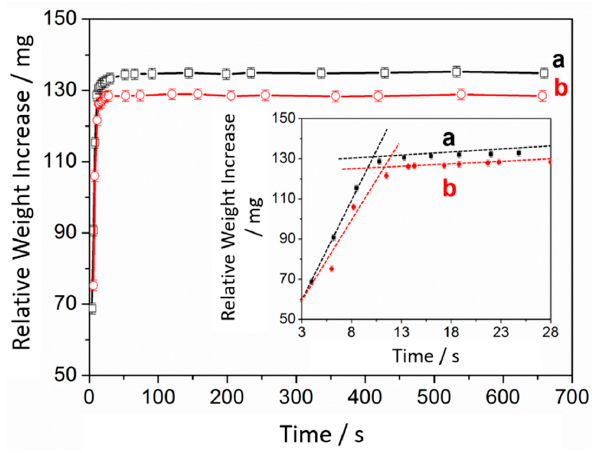
Figure 18. Magnetophoresis of NP@DTPA before ( a ) and after ( b ) the binding of Dy 3 + ions (magnet distance = 0.40 cm) showing the decrease of magnetization in the presence of the lanthanide ions and the slower magnetophoretic rate (inset) (adapted with permission from [43]).